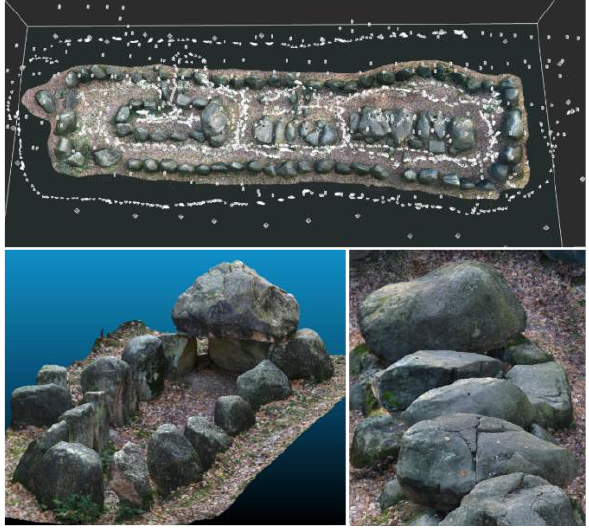
Figure 4: TLS, terrestrial images and UAV orientations (top), detailed view of the calculated mesh (bottom).